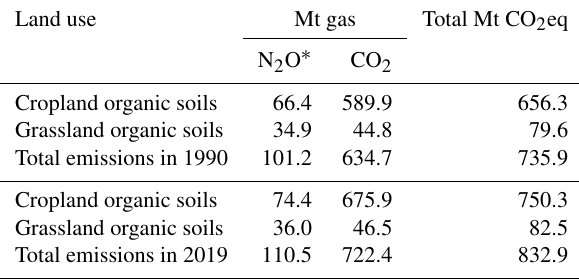
Table A1. Global emissions in 1990 and 2019 by gas and by land use.